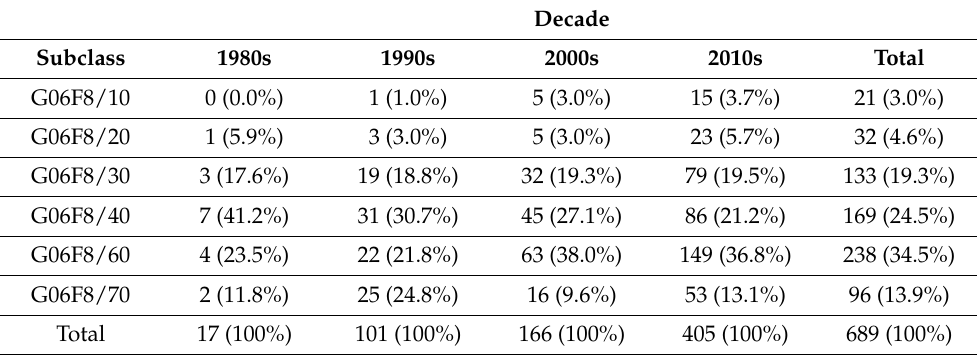
Table 5. Joint distribution of DOSD patent activity for CPC subclasses and decades.